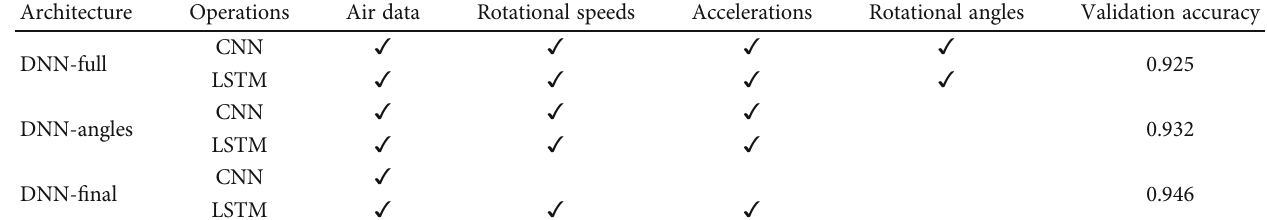
Figure 6: DNN-full; this “ full ” architecture adopts both CNN and LSTM operations for all variables that relate to the ADS evolution. CNN kernel size, fi lter numbers, LSTM nodes, and fully connection (FC) layers are speci fi ed directly following [50, 51]. Conv: convolutional; MP: max-pooling; FL: fl atten. Table 5: To simplify from a “ full ” DNN architecture to DNN- fi nal.